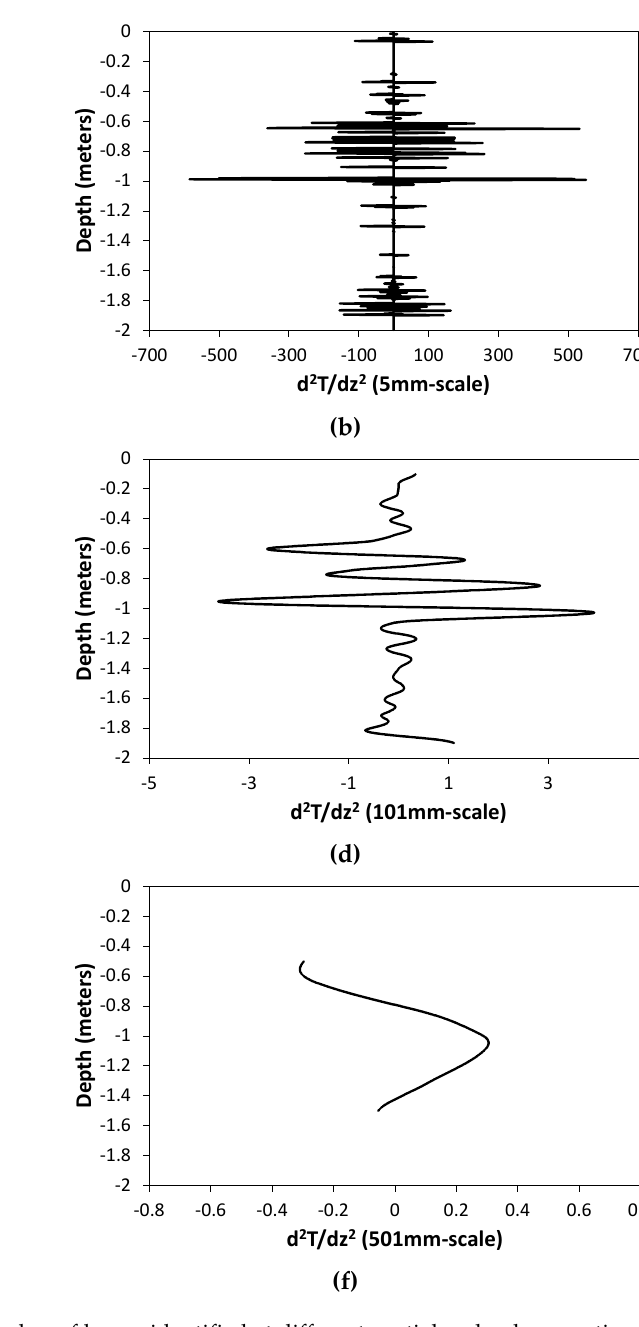
Figure 3. Illustration of the process of calculating the number of layers identified at different spatial scales, by counting turning points (peaks and troughs) in the d 2 T/dz 2 profile: ( a ) location of layer edges (“shoulders”) at 5 mm scale; ( b ) d 2 T/dz 2 at 5 mm scale ( c ) location of layer edges at 101 mm scale; ( d ) d 2 T/dz 2 at 101 mm scale; ( e ) location of shoulders at 501 mm scale; ( f ) d 2 T/dz 2 at 501 mm scale.